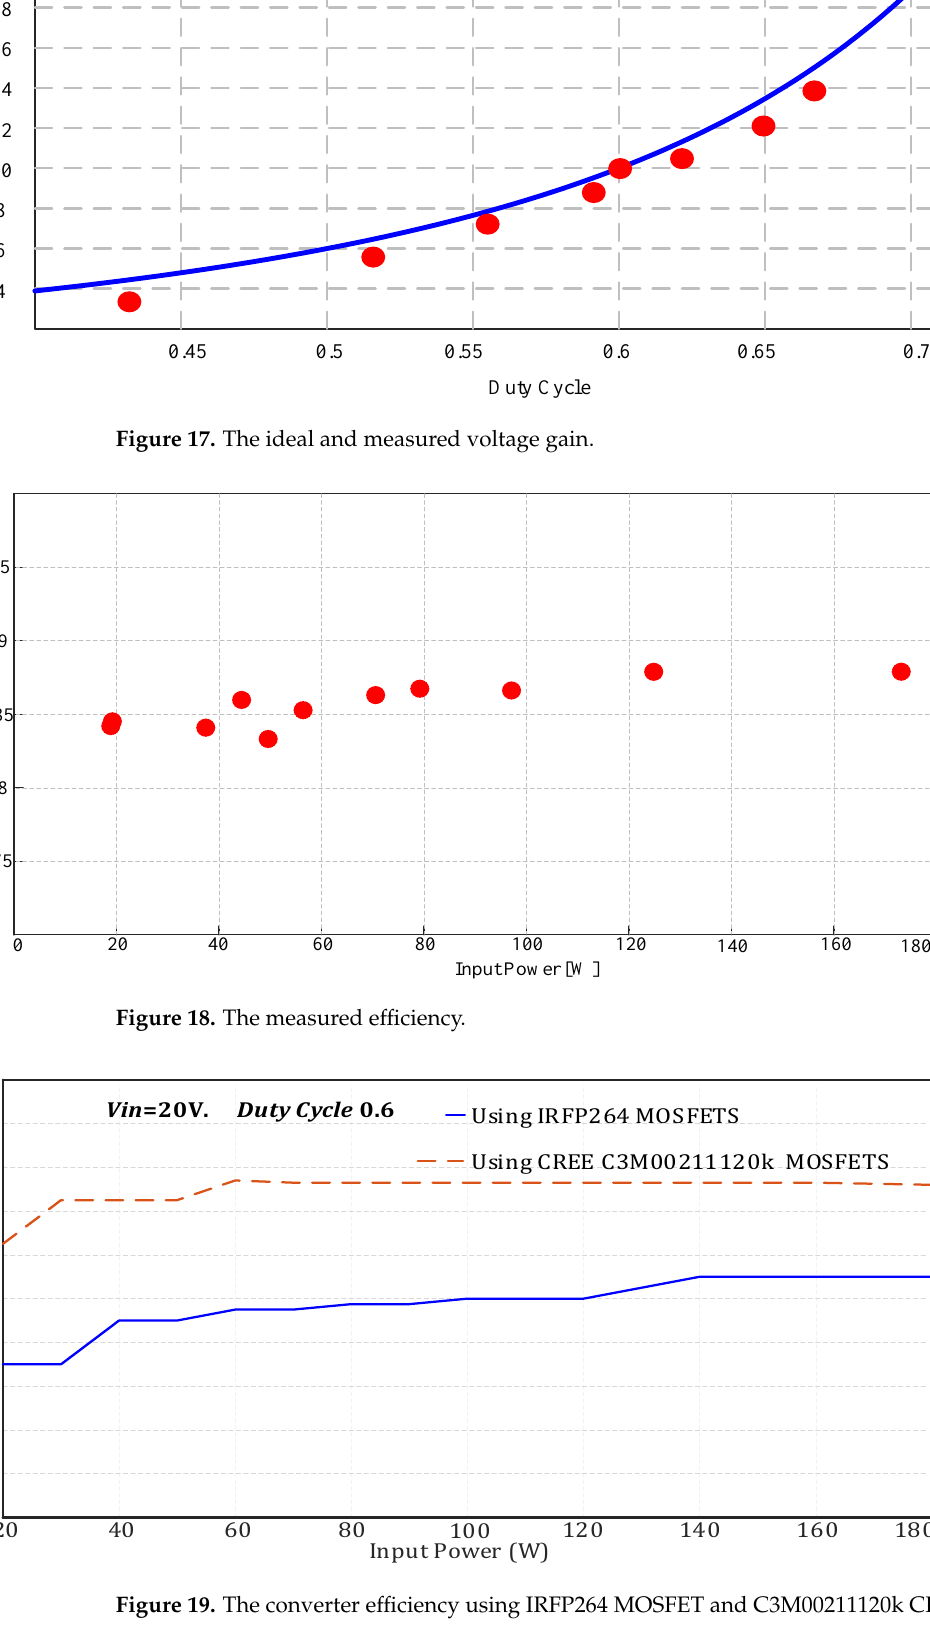
Figure 19. The converter efficiency using IRFP264 MOSFET and C3M00211120k CREE MOSFET.